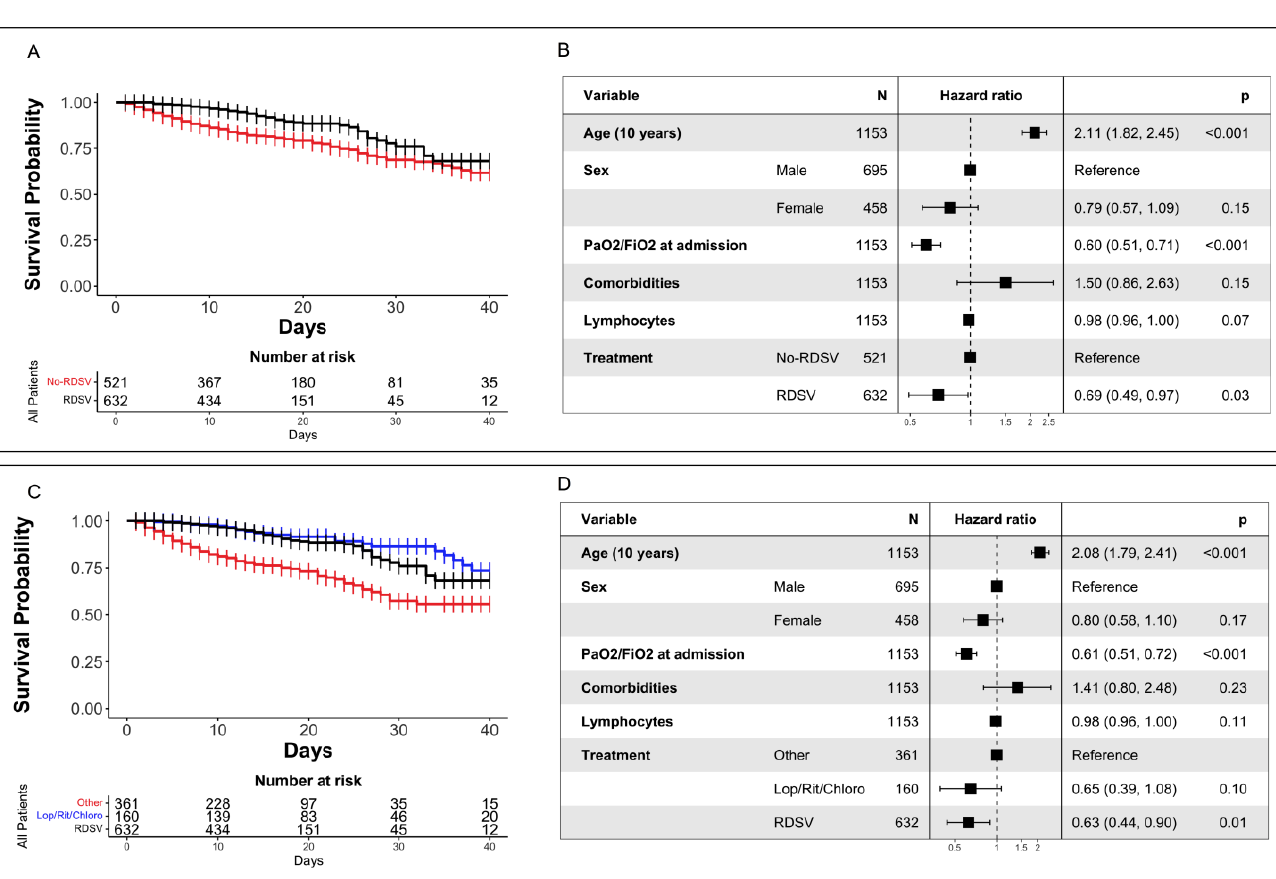
Figure 2. Analysis of primary endpoint. ( A ). Kaplan–Meier survival curve in the RDSV and no- RDSV groups. ( B ) Multivariable Cox analysis of factors associated with the primary endpoint in RDSV and no-RDSV groups. ( C ). Kaplan–Meier survival curve in RDSV, Lop/rit/chloro, and Other. ( D ) Multivariable Cox analysis of factors associated with the primary endpoint in RDSV, Lop/rit/chloro, and Other.